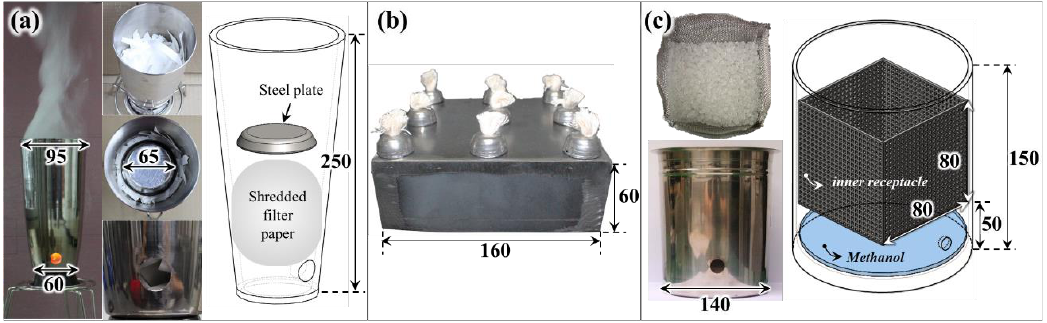
Figure 4. Photographs and schematics of smoke generators using ( a ) filter paper, ( b ) liquid fuel and ( c ) polymer pellets (unit:mm).